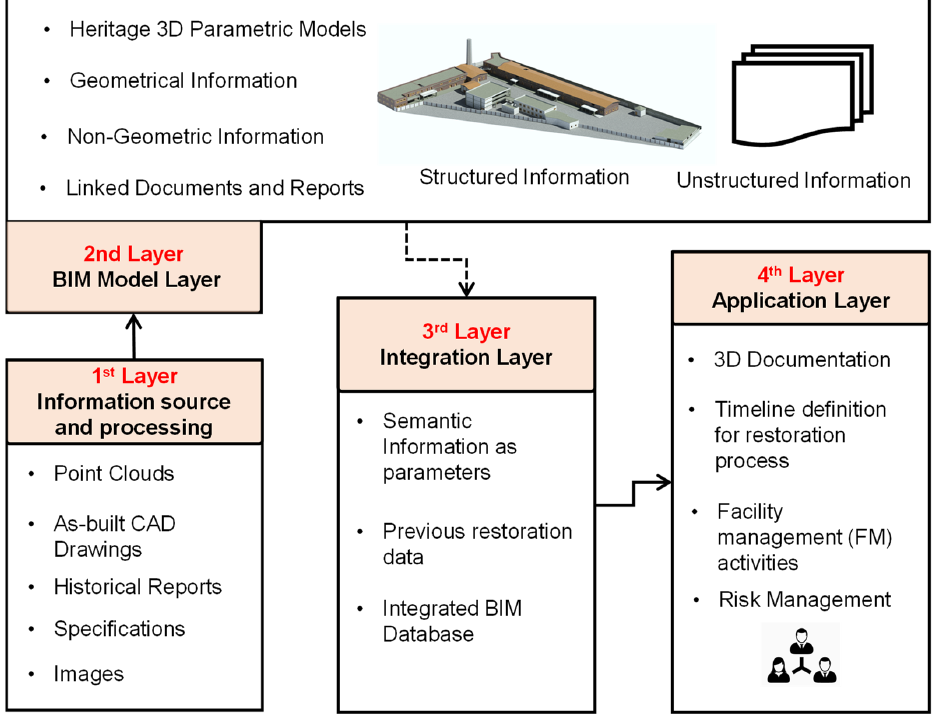
Figure 3. The system architecture of the proposed framework.